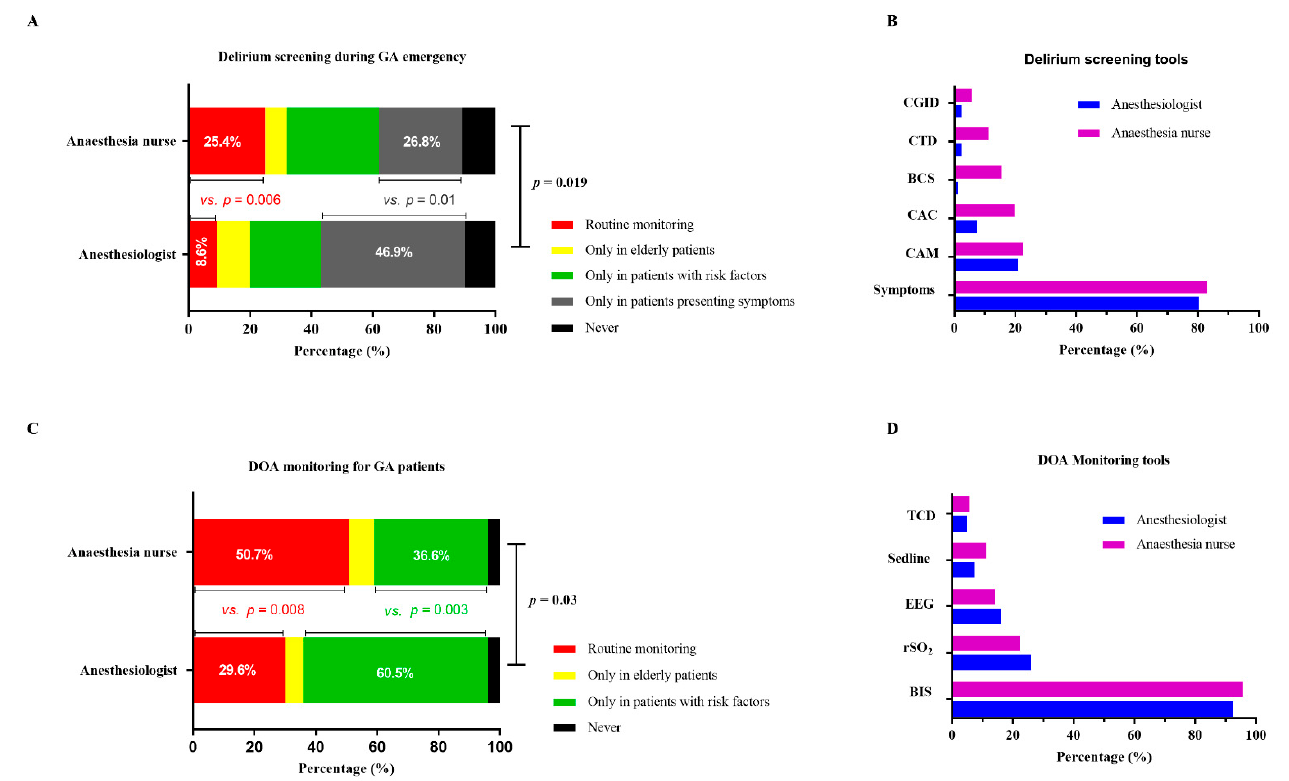
Figure 2. Assessment of ED and monitoring of DOA. ( A ) Delirium screening during GA emergency. ( B ) ED screening tools. ( C ) Routine monitoring of DOA for GA patients. ( D ) DOA monitoring tools. ED, emergence delirium; DOA, depth of anesthesia; GA, general anesthesia.